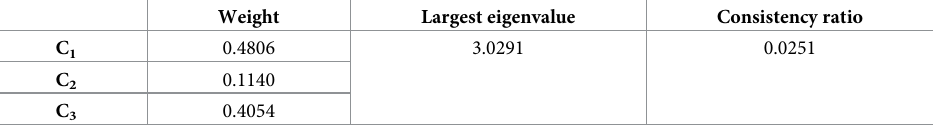
Table 18. Values of the consistency ratio and fuzzy weight vectors and crisp weights in emergency response